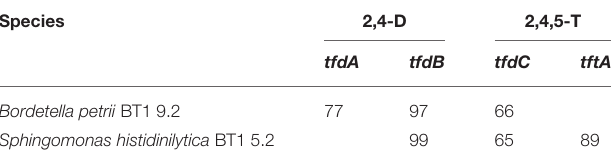
TABLE 2 | Summary of species and genes involved in break-down of 2,4-D (columns 2,4-D) and 2,4,5-T (column 2,4,5-T).